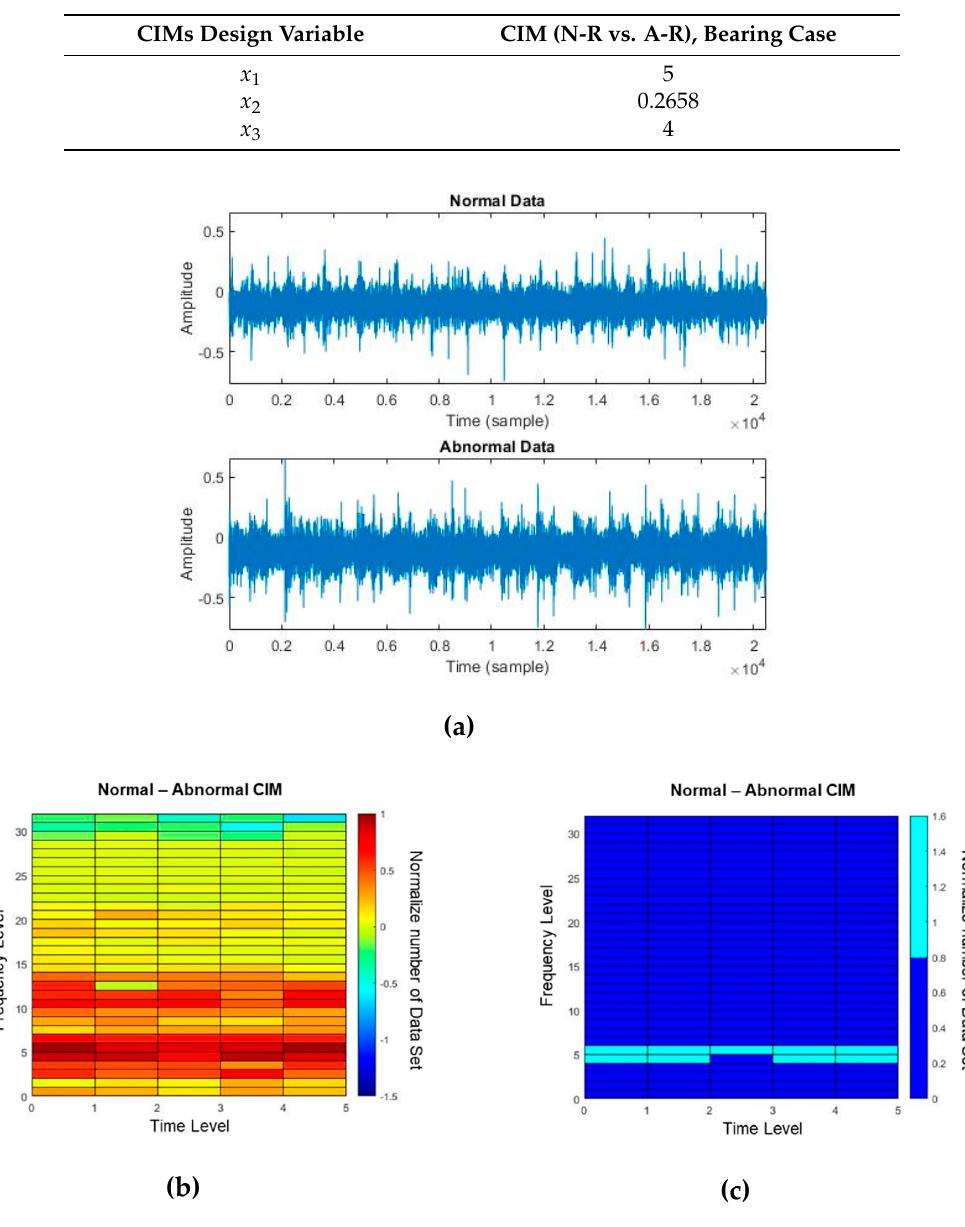
Figure 15. ( a ) Normal and abnormal data in time series, ( b ) CIM for N-R vs. A-R, ( c ) selected OWs ( R c ≥ 0.8) in CIM for N-R vs. A-R.